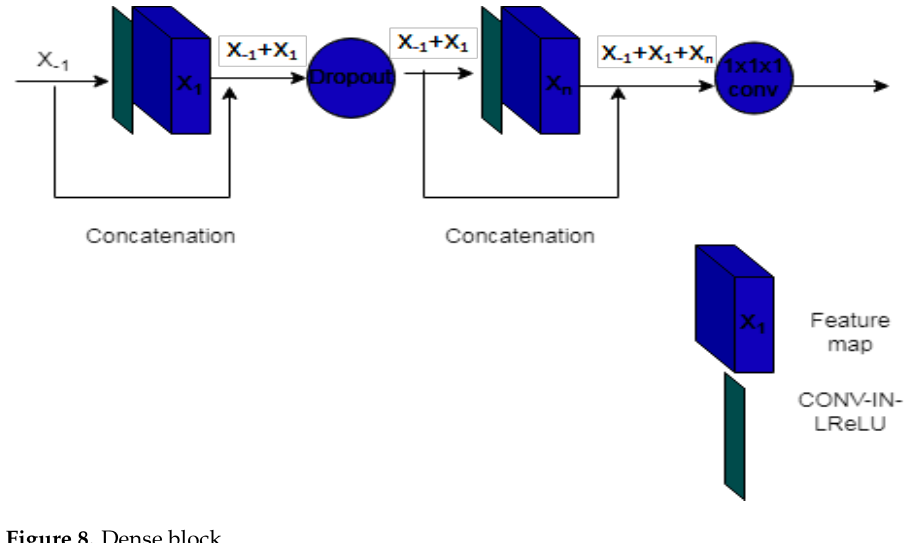
Figure 8. Dense block.